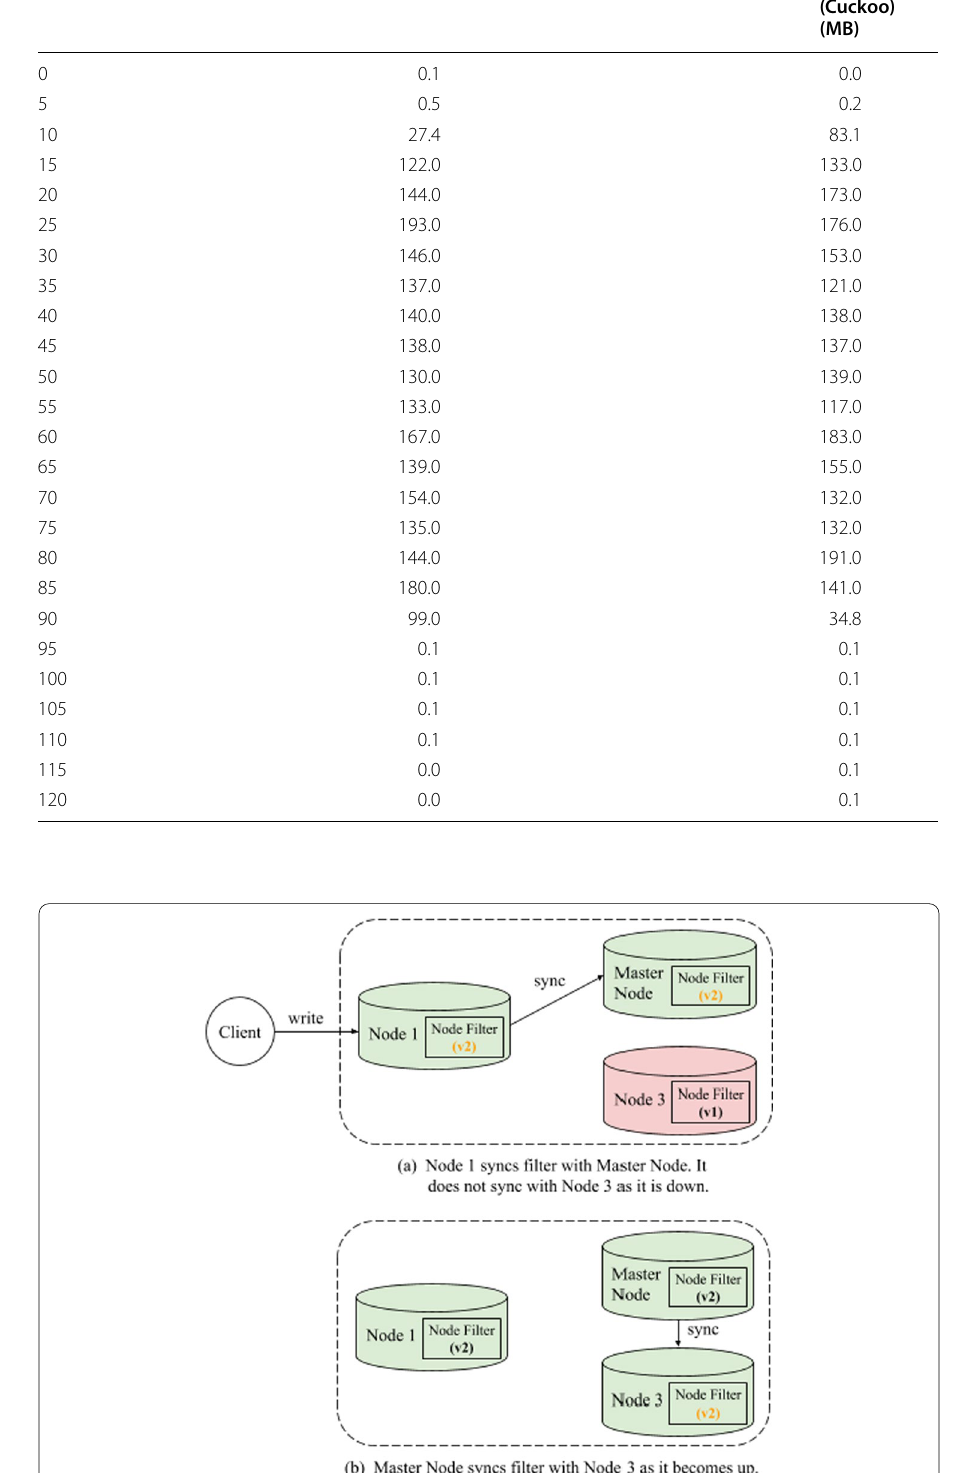
Table 13 Network bandwidth consumption (outgoing) in megabytes by Node Filter Time ( n -th minute)